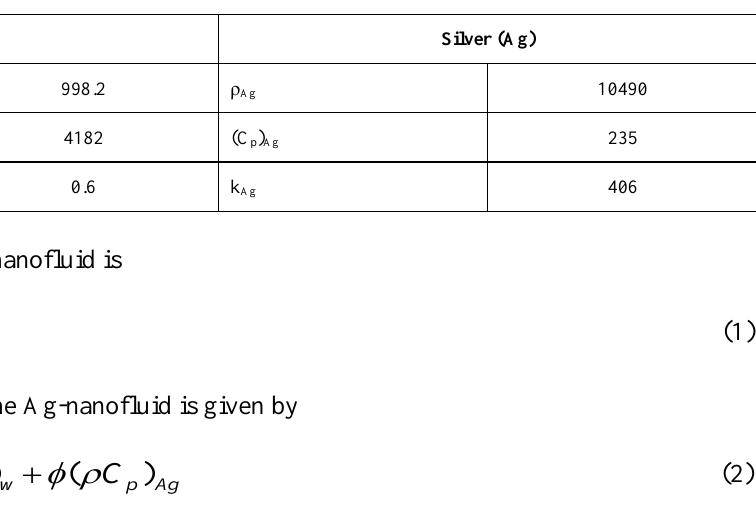
Table1. Properties of water and silver